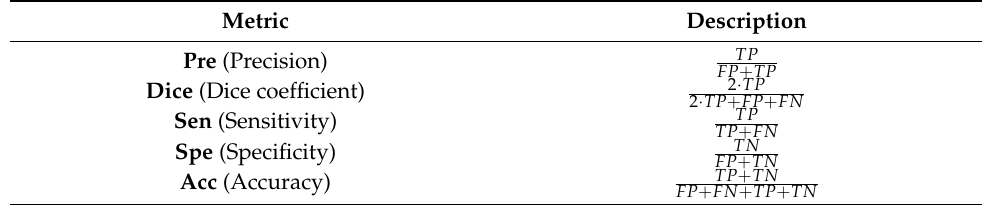
Table 1. Evaluation metrics.